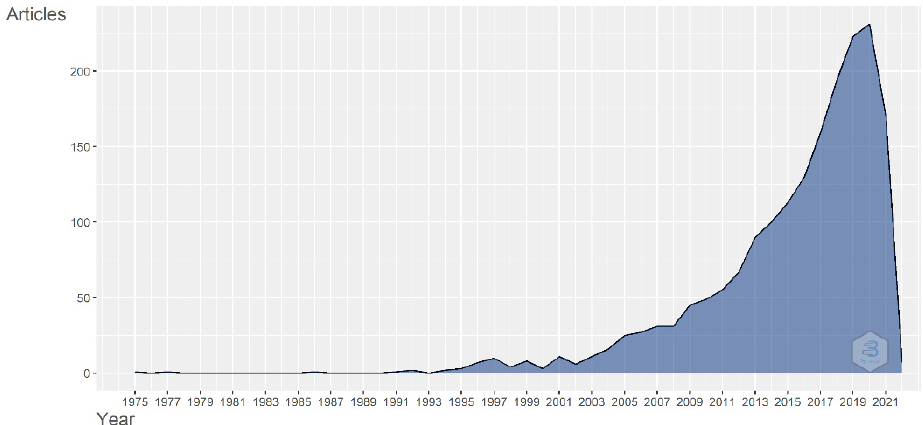
Figure 2. Annual scientific publication on metalworking fluids and sustainable machining operations.